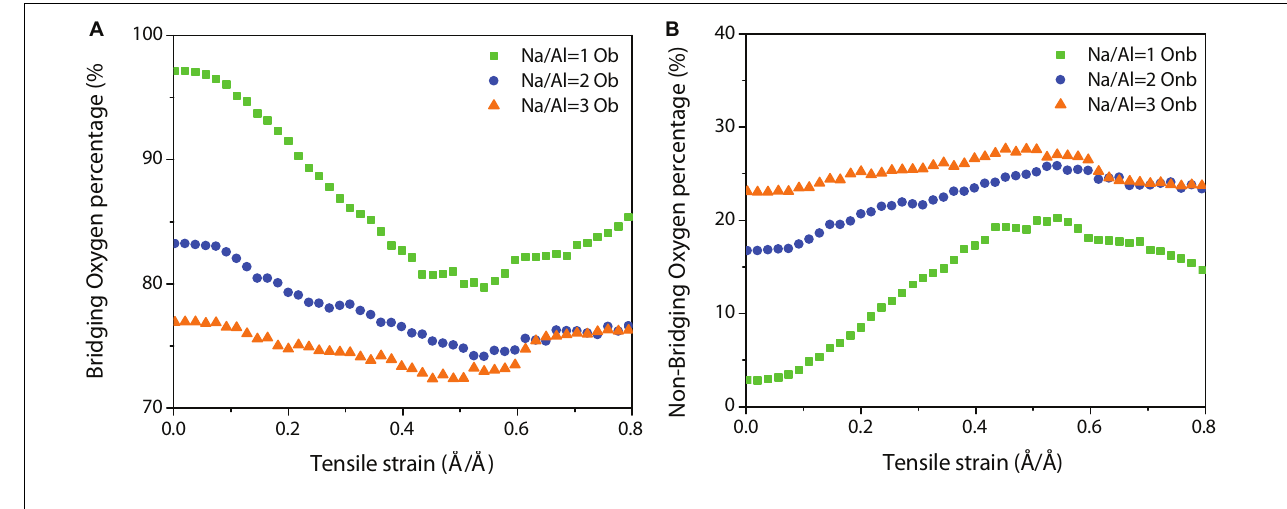
FIGURE 10 | Evolution of (A) bridging oxygen and (B) non-bridging oxygen as functions of